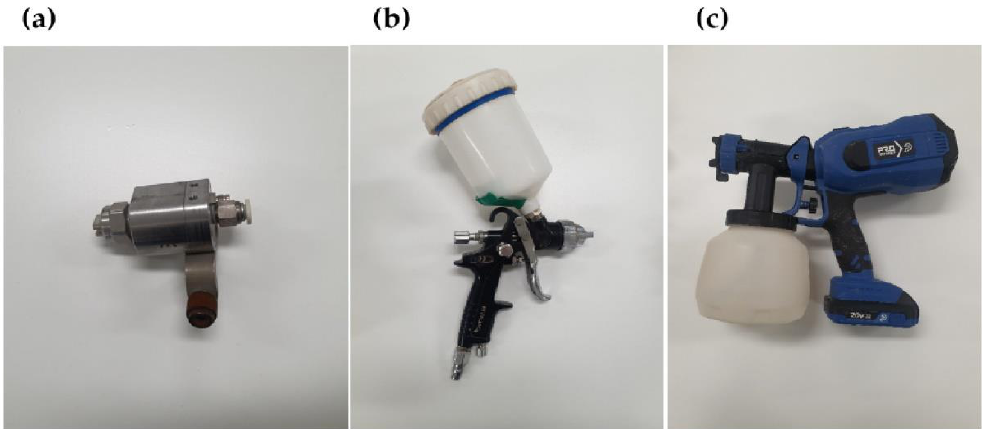
Figure 5. ( a ) Spray system, ( b ) gravity spray gun, and ( c ) automatic injection gun. The gravity spray device (manufacturer: Bluetech(100, Dalseong-ro, Jung-gu, Daegu,